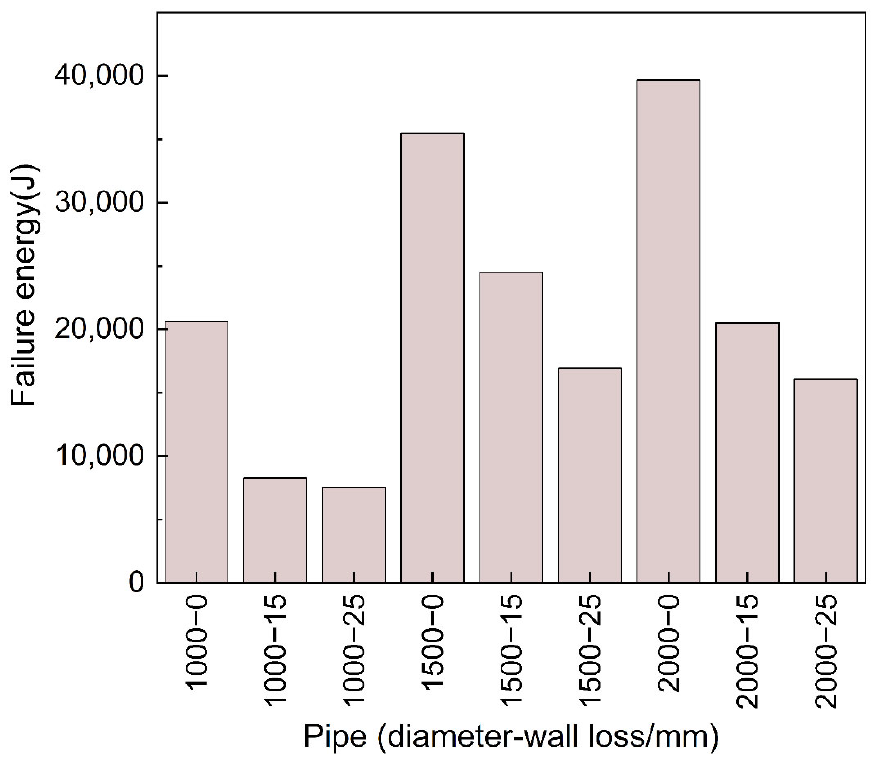
Figure 15. Comparison of failure energy of RCPs with 15-mm, 25-mm, and without wall losses.